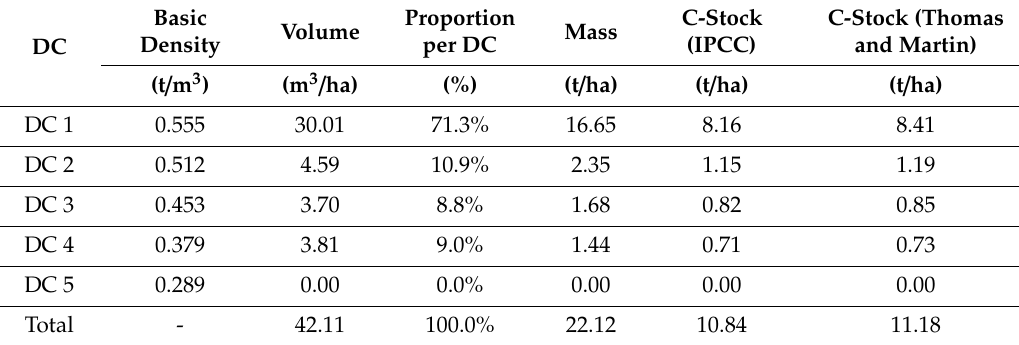
Table 7. Average values for the main parameters of deadwood and carbon estimated distribution per decay classes (DC) in the pine type.